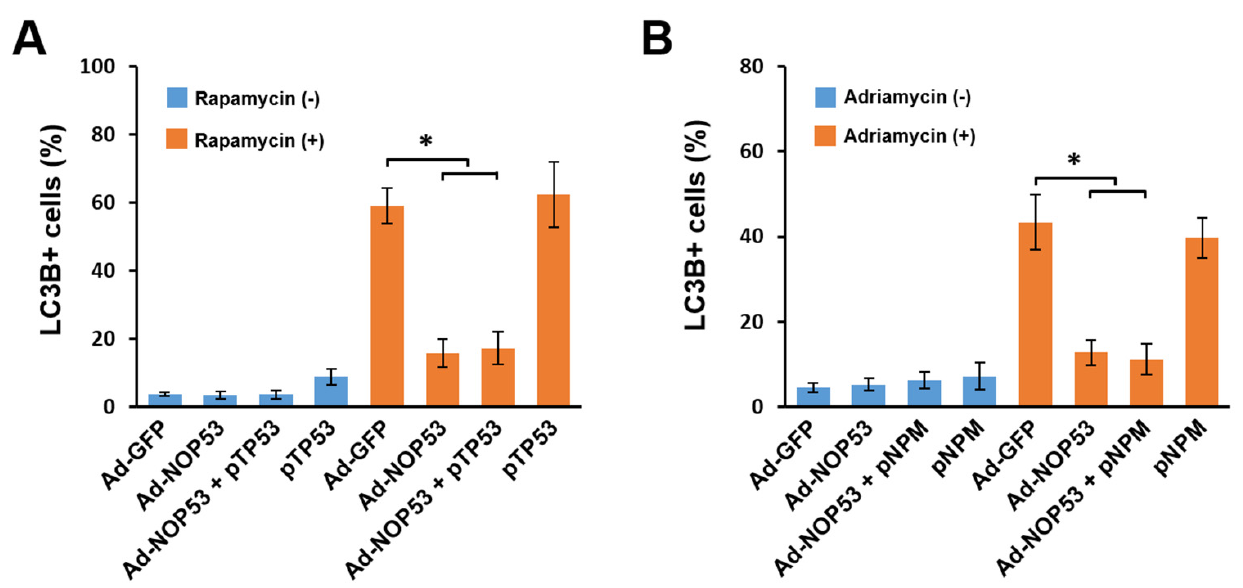
Figure 2. NOP53 suppresses autophagy through the p53- and NPM-independent pathways. ( A ) Cells were singly transduced with a p53 − expressing plasmid (p53) or Ad-NOP53 or co-transduced with Ad-NOP53 and p53 in the presence or absence of 10 ng/mL rapamycin, followed by immunocytochemical staining with an anti-LC3B antibody. Cells with LC3B-positive spot formations were counted, and the ratio is presented. Data from three independent experiments are shown as the means ± SD; * p < 0.01. ( B ) Cells were singly transduced with NPM − expressing plasmid (pNPM) or Ad-NOP53 or cotransduced with Ad-NOP53 and pNPM in the presence or absence of 10 ng/mL Adriamycin, followed by immunocytochemical staining with an anti-LC3B antibody. Cells with LC3B-positive spot formations were counted, and the ratio is presented. Data from three independent experiments are shown as the means ± SD; * p < 0.01.